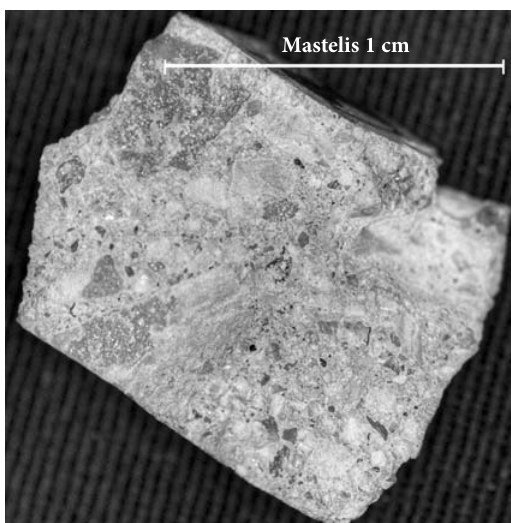
Fig. 2 . The example of tested